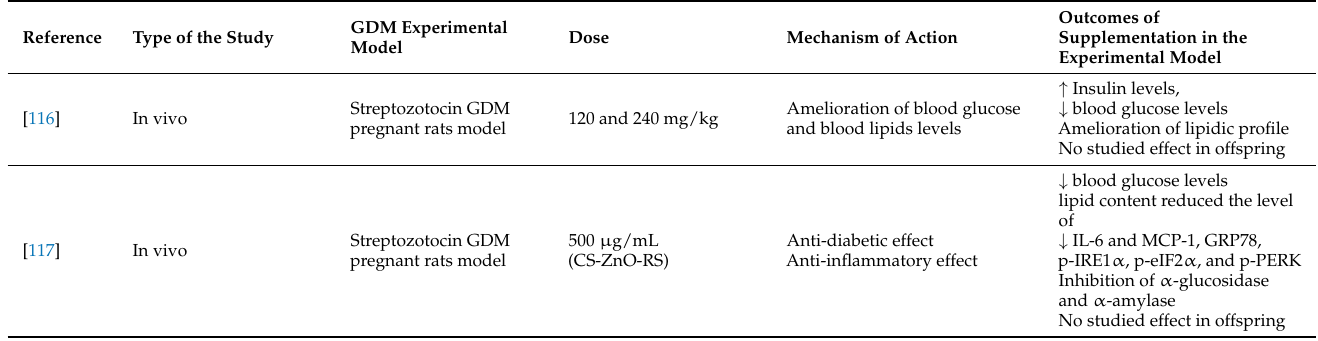
Table 2. Studies using resveratrol in the treatment of models of gestational diabetes miletus (GDM) in